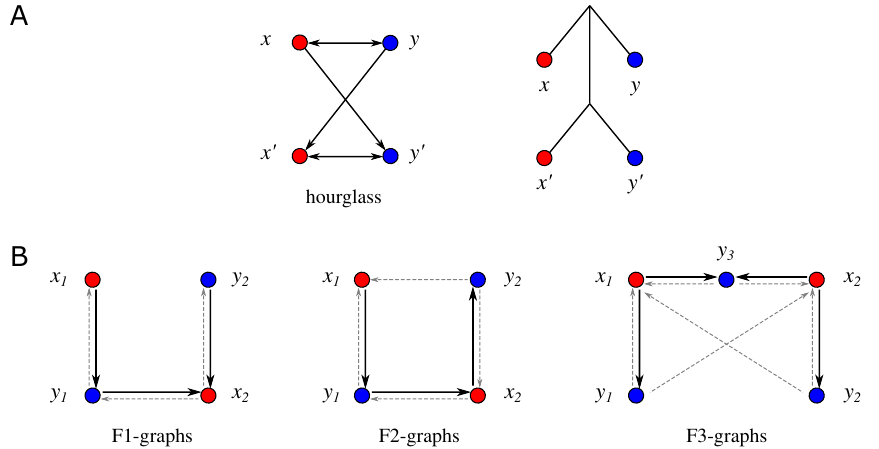
Figure 1. ( A ) An hourglass as the characteristic forbidden induced subgraph of beBMGs and its non-binary explaining tree. ( B ) The three classes of forbidden induced subgraphs of 2-colored BMGs (see Definition 6 below). The gray-dashed arcs may or may not